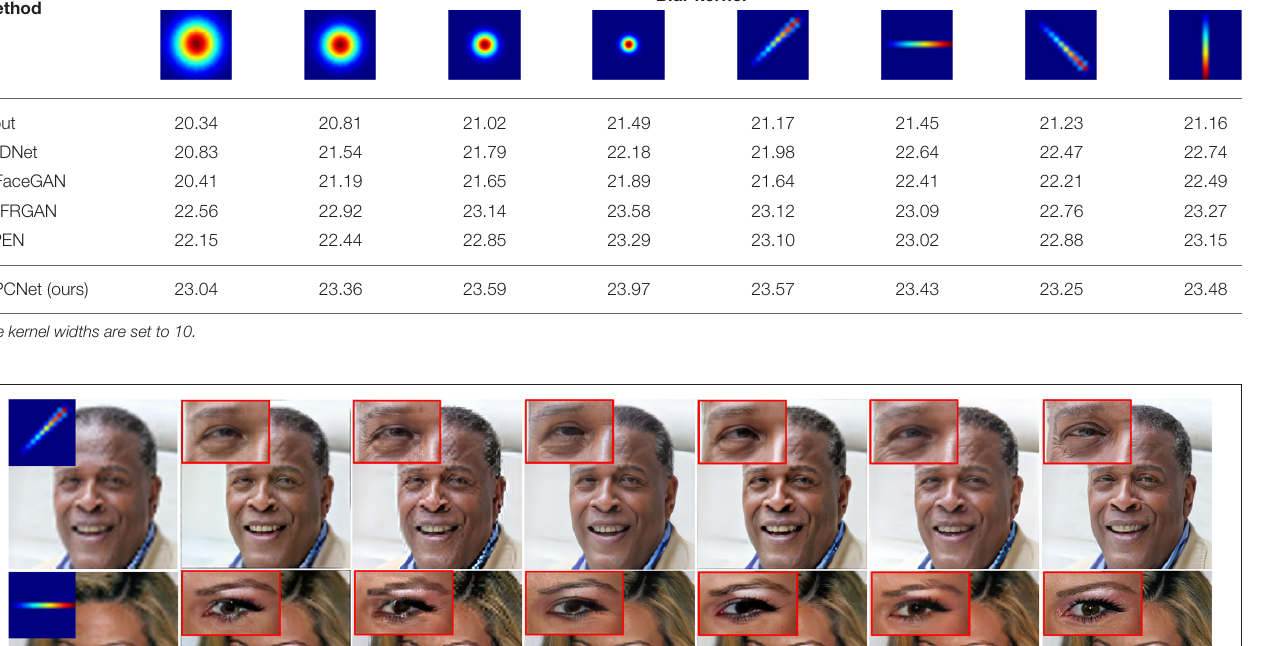
TABLE 5 | Peak signal-to-noise ratio results achieved on noise-free degradations with different blur kernels. Method